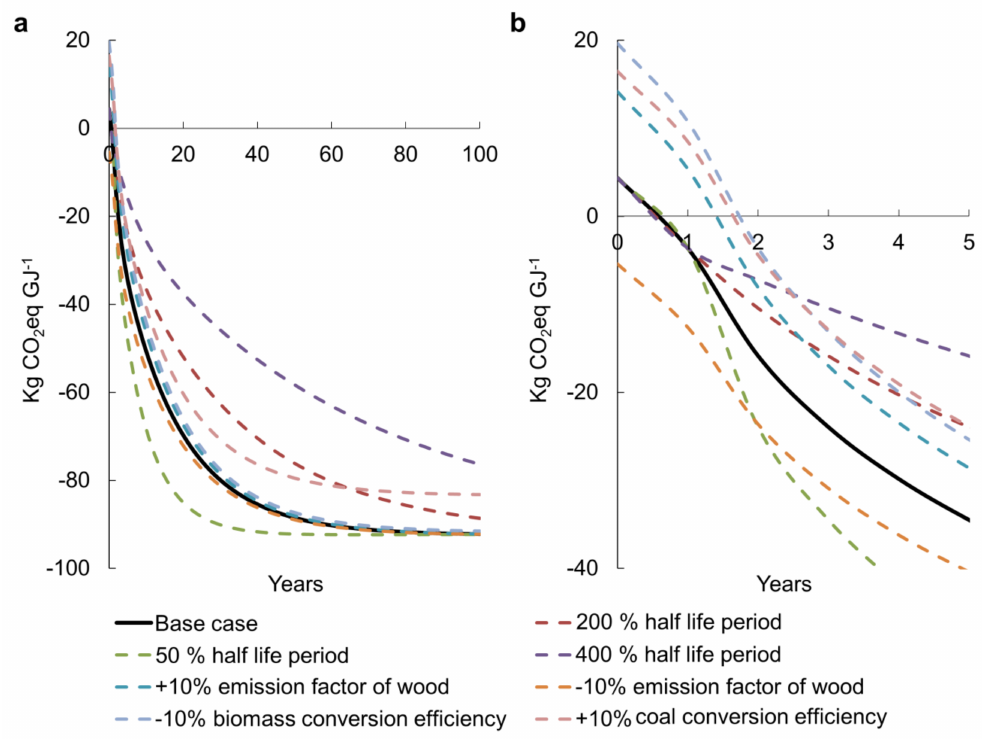
Figure 5. ( a ) Cumulative GHG emissions in a 100-year perspective from biomass use at the plant relative to continued use of coal ( x -axis). The influence of varying biomass half-life periods, emission factors and plant efficiencies on the 100-year cumulative GHG emission profile of shifting from coal to biomass are illustrated with dotted lines. ( b ) Highlights the GHG emission profiles the first five years. Table 4. Influence of the sensitivity analysis on estimated carbon debt and the period it takes to reach 50% reduction of GHG emissions in the biomass scenario compared to the reference